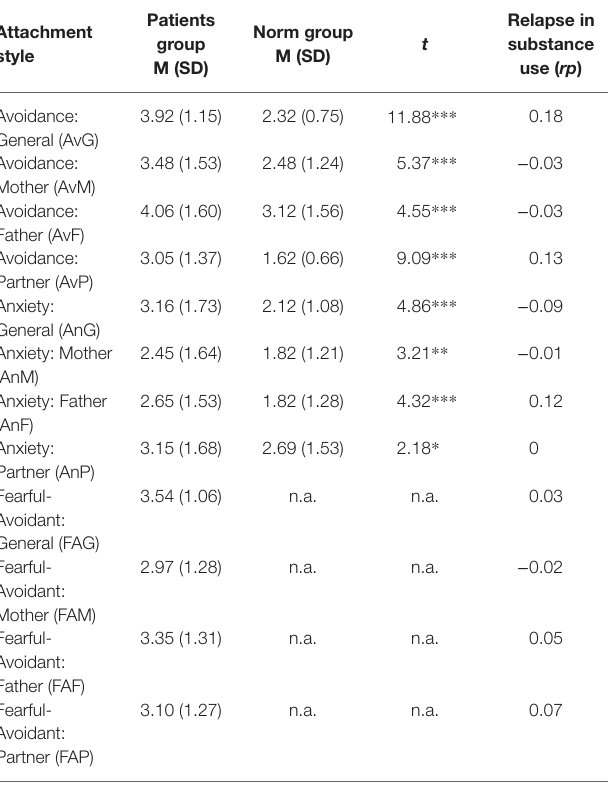
TABLE 1 | ECR-RS scales (mean scores and standard deviation) for patients in treatment for opiate addiction compared to normative values (non-clinical groups) and scales correlations with relapse in substance use during treatment ( rp